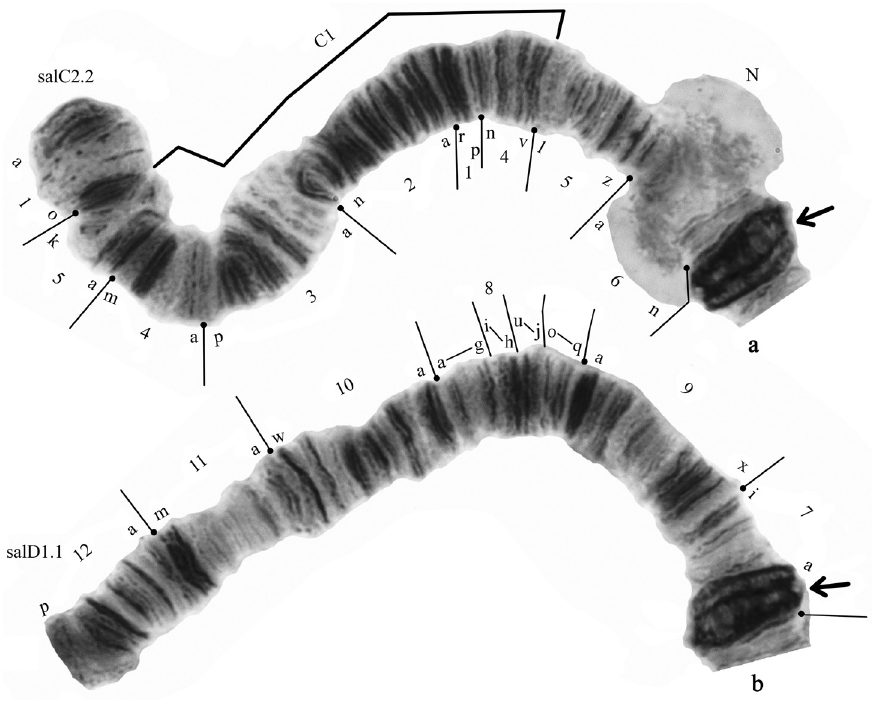
Figure 5. Banding sequences in the arms C and D of G. salinus . Key: a homozygotes salC2.2 b homozy- gotes salD1.1 Designations as in Fig.